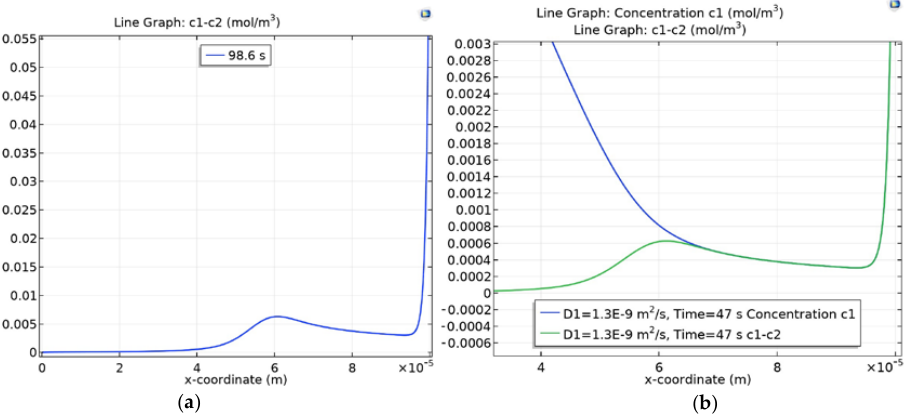
Figure 1. ( а ) Graph of the space charge in the diffusion layer; ( b ) Comparison with the graph of the concentration of C 1 cations near the cation-exchange membrane (CEM) when using overlimiting current modes in the dimensional form.